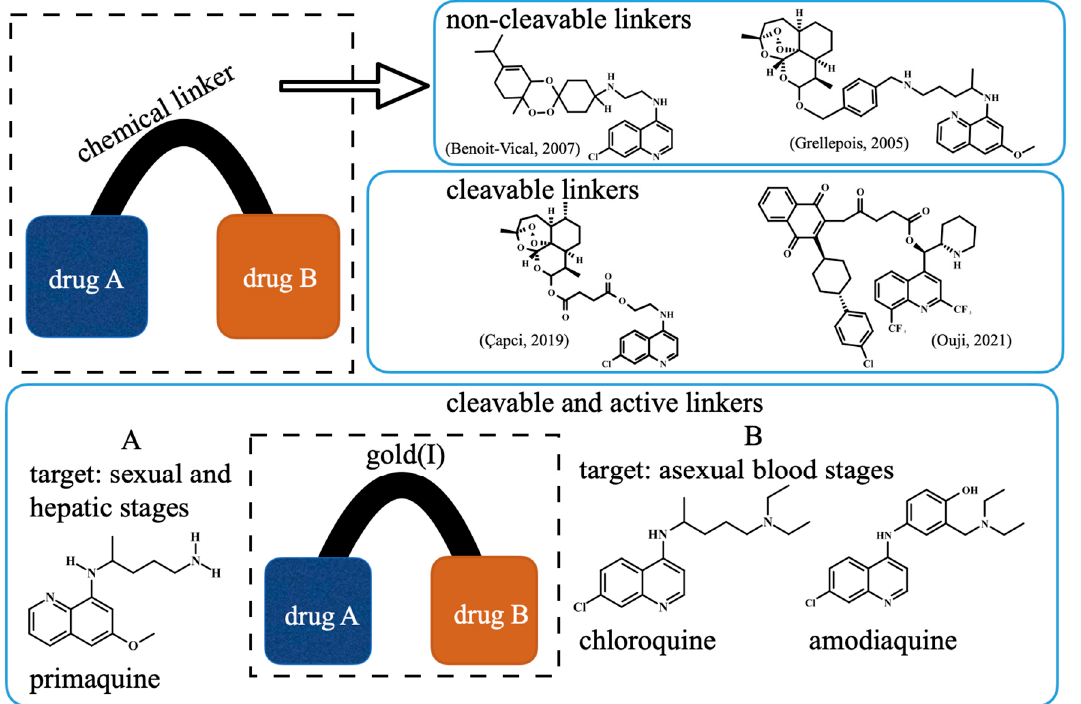
Figure 1. Panel ( A ) Schematic of the concept of hybrid-based drugs against malaria, highlighting the nature of chemical linkers and showing representative hybrids containing aminoquinolines as one of the components (references given in brackets). Panel ( B ) The concept of designing hybrid compounds containing gold(I) as a dual cleavable chemical linker and an antimalarial payload. [9–12]